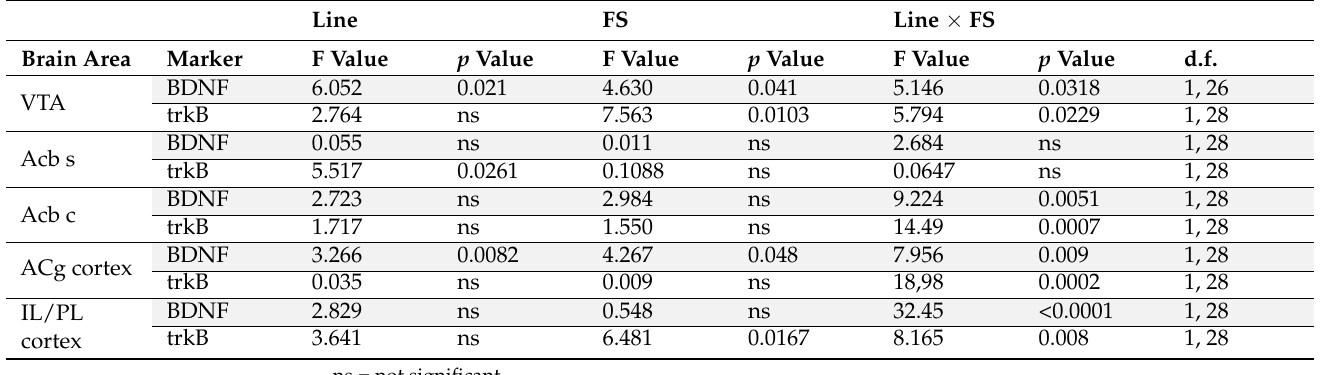
ns = not significant.